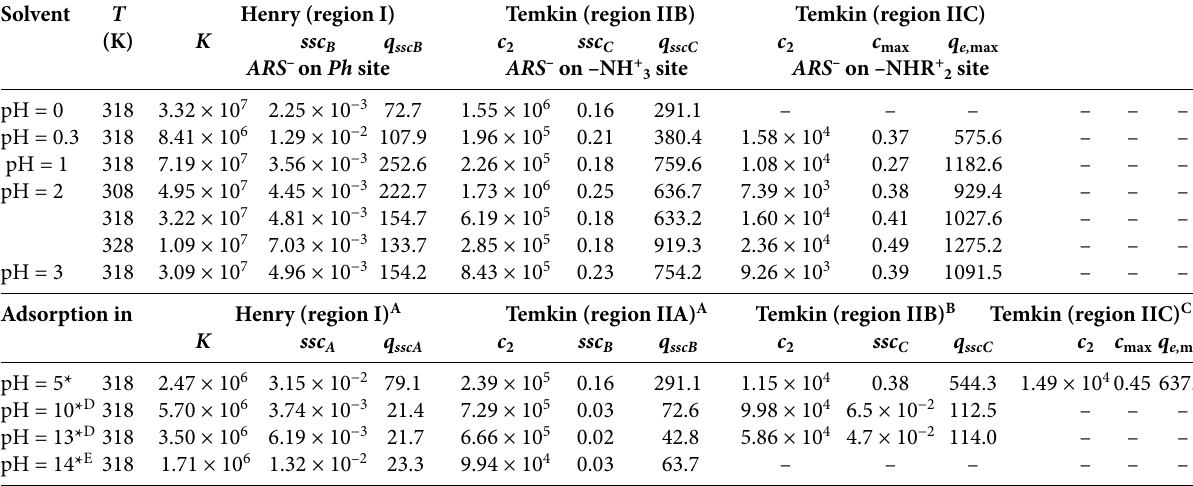
Table 2. Adsorption equilibrium constants obtained from the Henry and Temkin equations based on the ARIAN model and experimental ssc A , q